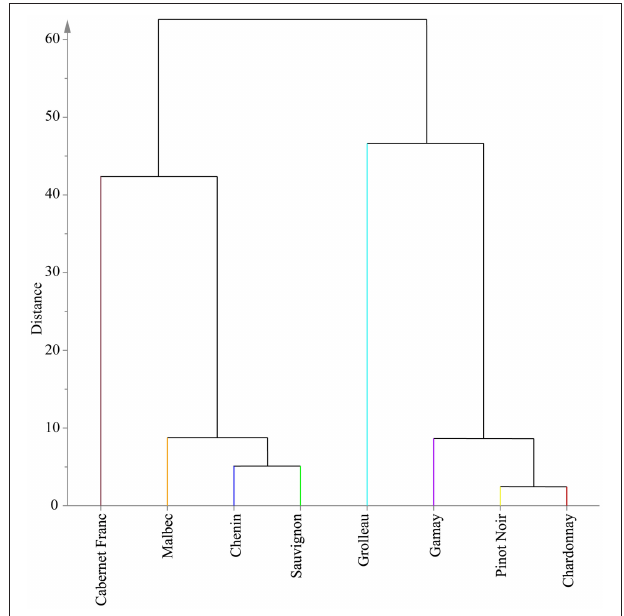
FIGURE 6 | Dendrogram of HCA based on Ward’s clustering of 22 SSR markers of the eight